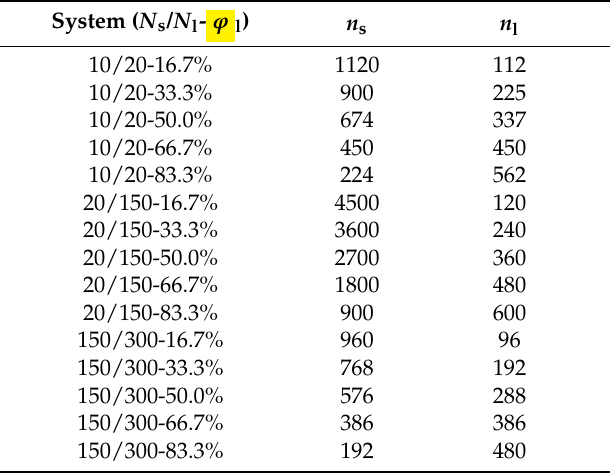
Table 1. Compositions of bidisperse polymer melts 1